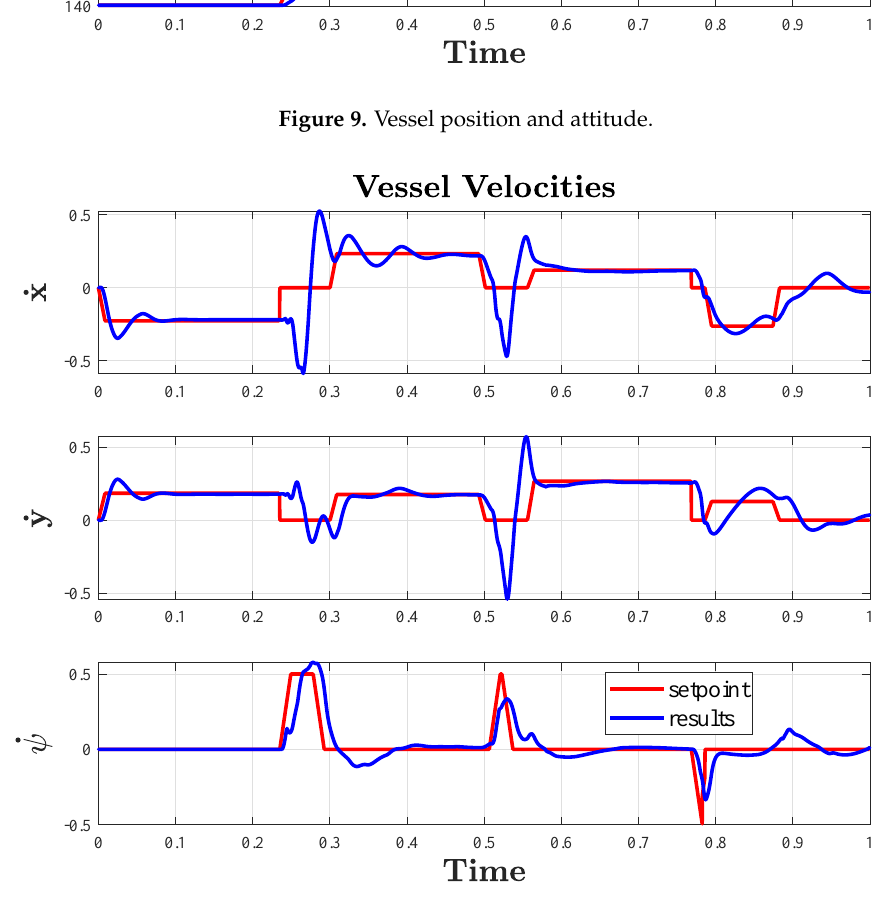
Figure 10. Vessel